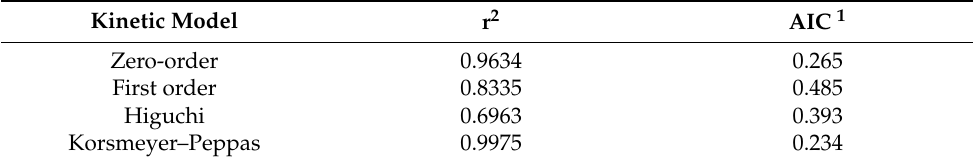
Table 3. Kinetic model data for the evaluation of diclofenac release from nanoparticles. Kinetic